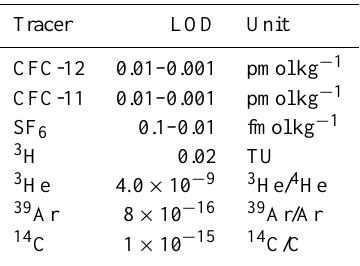
Table 1. Detection limits of transient tracers. The presented val- ues are approximate values that can deviate between different sys- tems and the measurement conditions, e.g., lab or onboard measure-